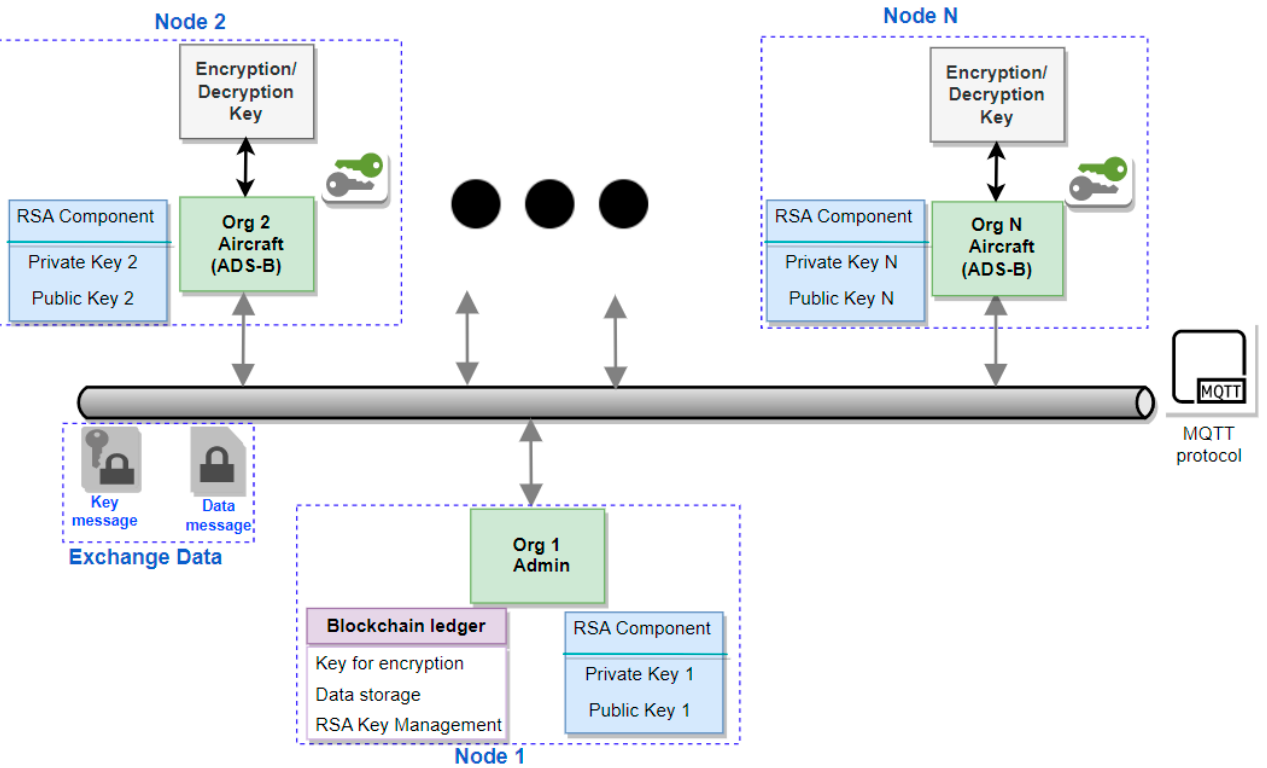
Figure 6. Blockchain network topology for key and data exchange.